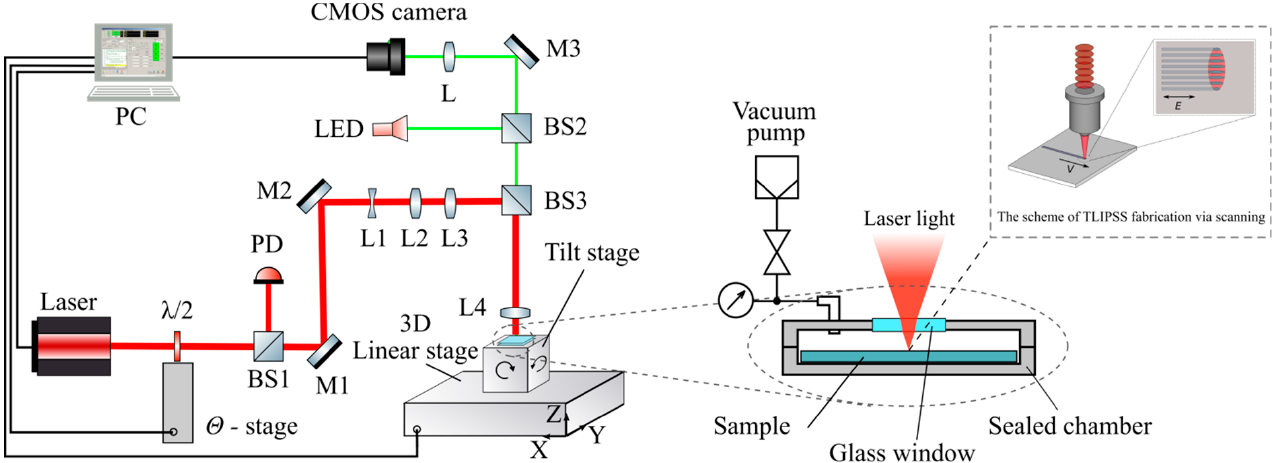
Figure 1. Experimental setup for TLIPSS formation in air and a low